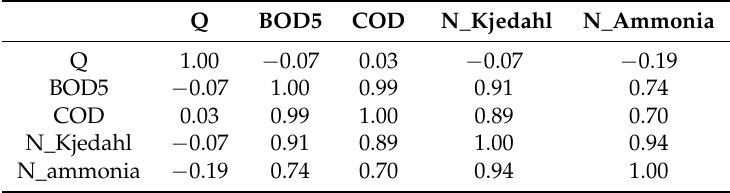
Table 2. Correlation among real sensors on all weather